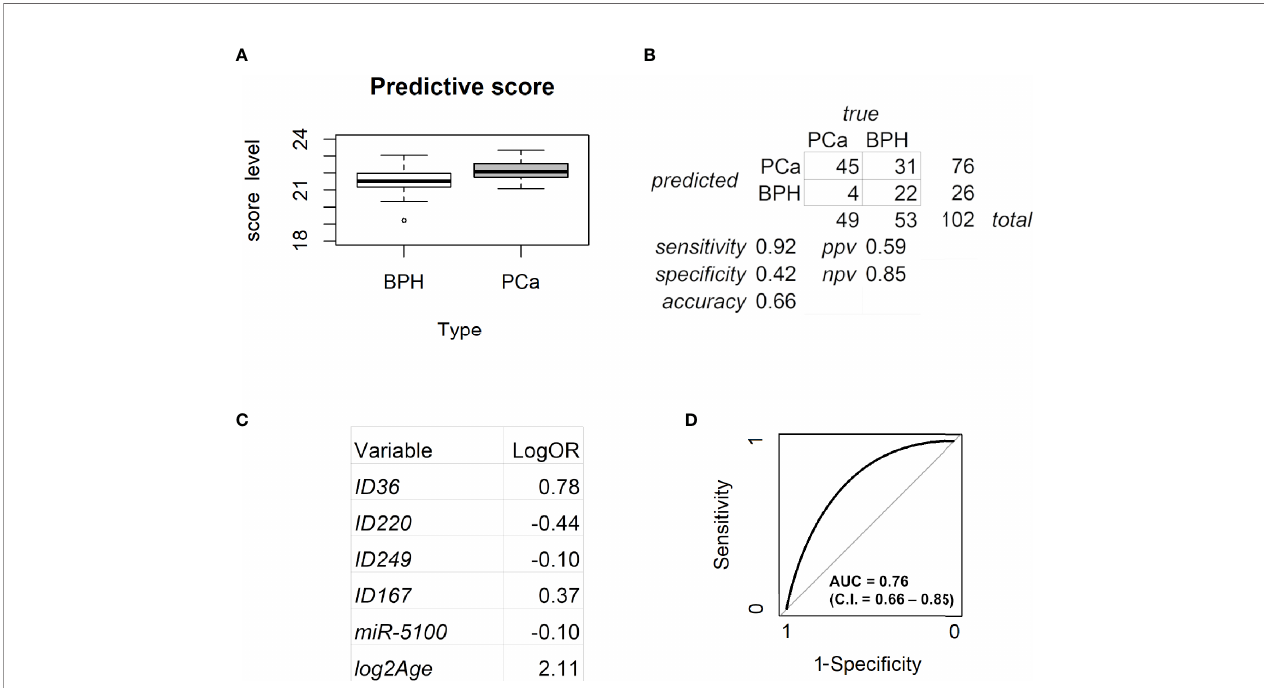
FIGURE 4 | Analysis of the predictive model. (A) Box plot for the predictive score discriminating BPH from PCa. Data are shown as the sum of the variable levels multiplied by the regression coef fi cients as reported in panel C. (B) Contingency table corresponding to the cutoff of 21.34 for the predictive score. (C) Coef fi cients of the logistic regression for the selected variables. (D) ROC curve of the score obtained by combining age, miR-5100, and four metabolites after penalized logistic regression. BPH, benign prostatic hyperplasia; PCa, prostate cancer.